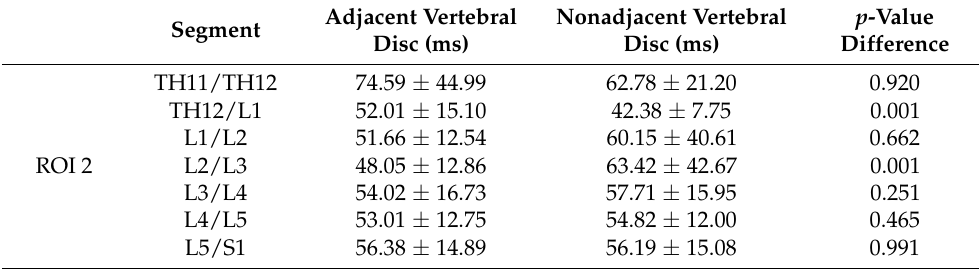
Table 1. Inner part (IP) of the intervertebral disc. Mean T2 relaxation time values ± standard deviation (SD) for adjacent and nonadjacent IVDs of the inner part (IP) represented by ROI 2, ROI 3, ROI 4 and ROI